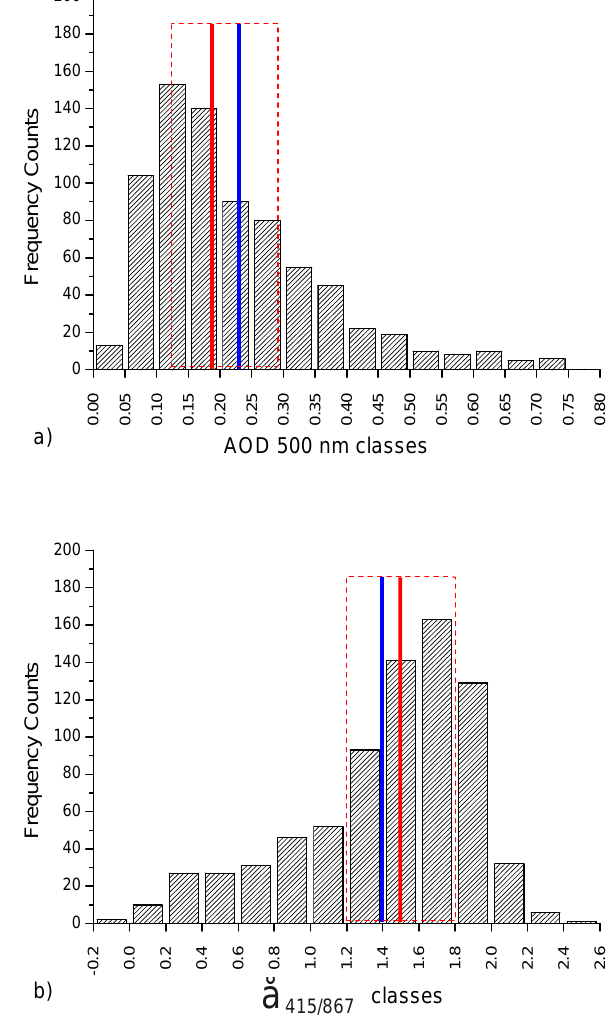
Fig. 2. Frequency distributions of the daily: (a) AOD averages and (b) the ˚Angstr¨om coefficient over Athens, for the period 2006– 2008. The blue line corresponds to the average of the daily values. The red continuous line represents the median and the red dashed box delimits the 1st and 3rd quartiles, respectively.